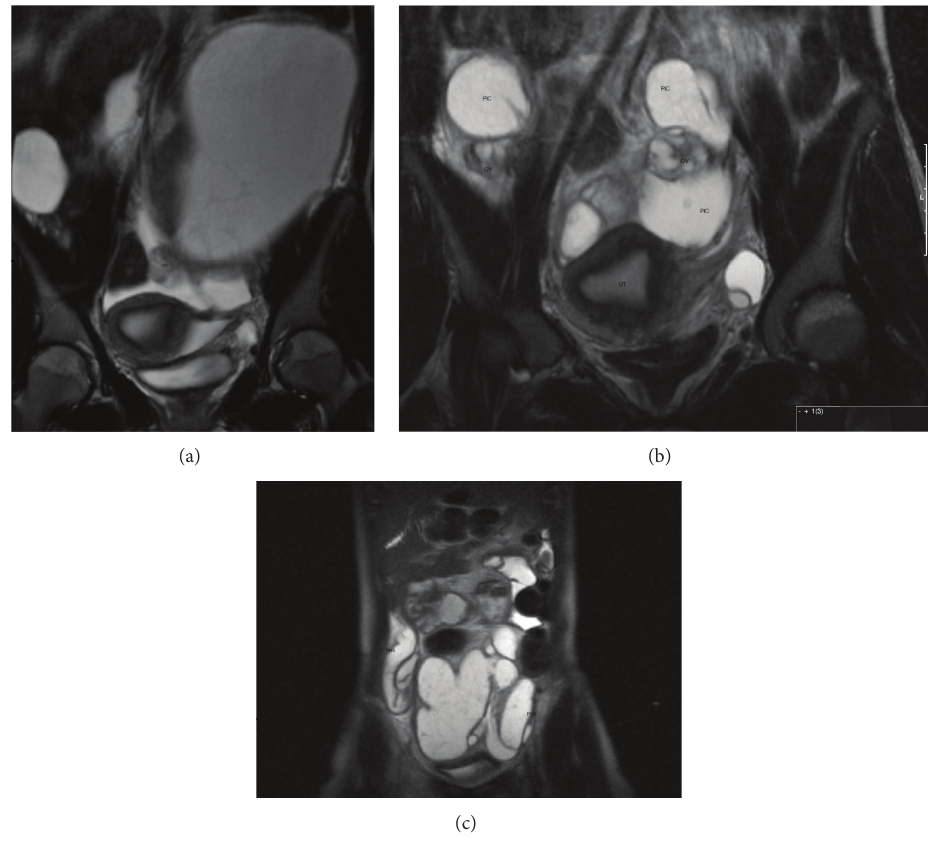
Figure 5: (a) Coronal T2 MR image demonstrating both ovaries (Ov) surrounded by cystic fluid collections. (b) Coronal T2 MR image shows both ovaries (Ov) surrounded by peritoneal inclusion cysts (PIC) after drainage. UT = uterus. Bl = bladder. (c) Coronal T2 MR image demonstrating a “pseudohydrosalpinx” (PHS) bilaterally. “Spider web” septations are seen within the peritoneal inclusion cyst that has decreased in size after